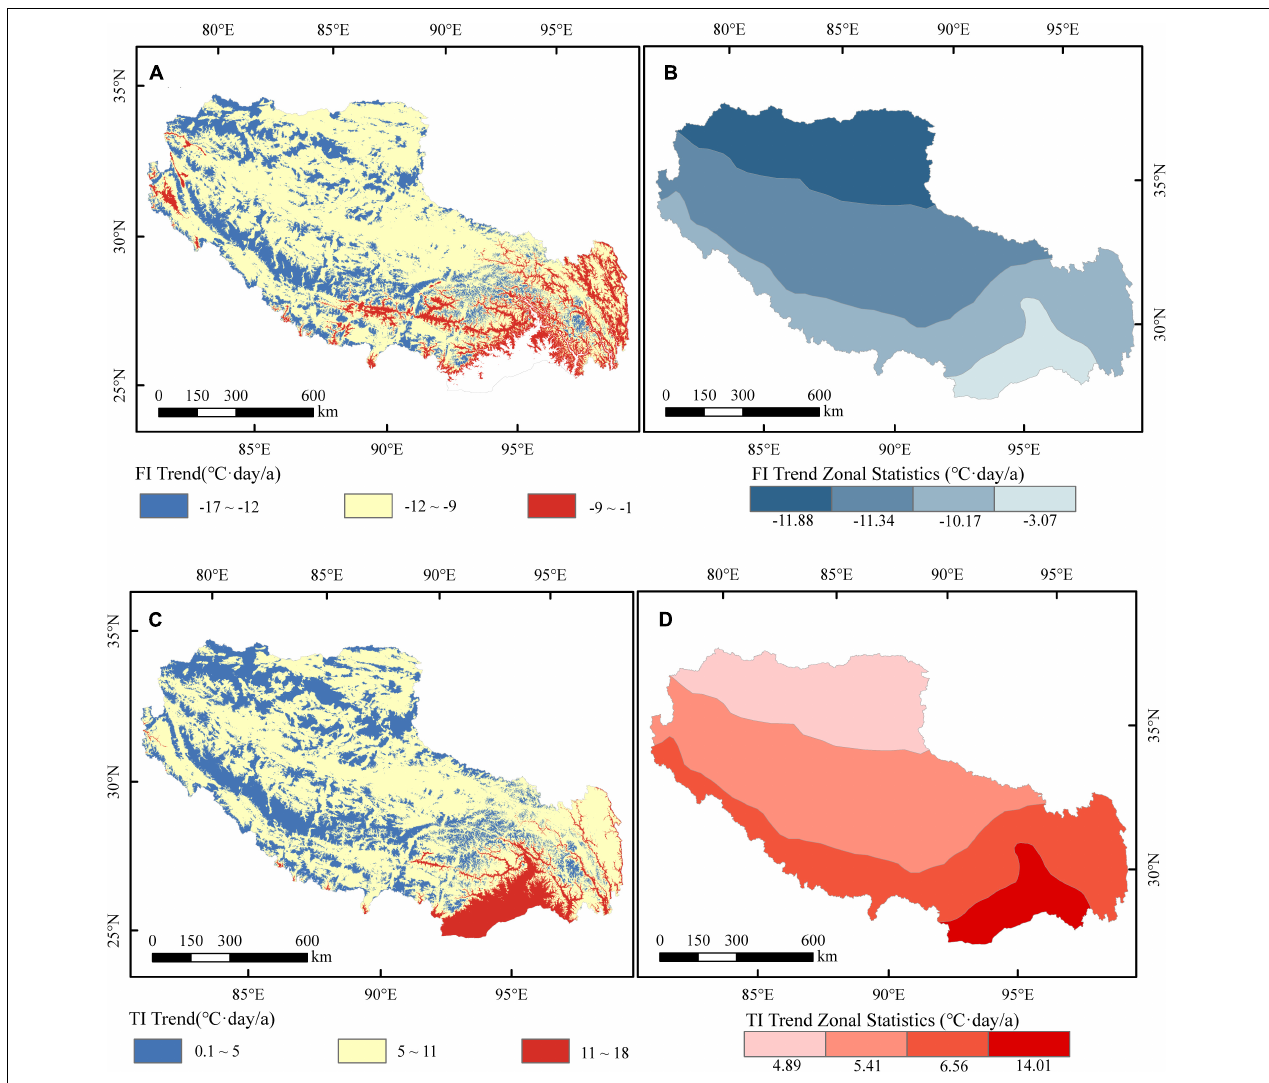
FIGURE 4 | (A) Trends ( ◦ C · day/a) for the FI over Tibet from 1978 to 2017 and (B) 4 parts zonal statistics. (C) Trends ( ◦ C · day/a) for the TI over Tibet from 1978 to 2017 and (D) 4 parts zonal statistics. Note that the white area has no FI and TI changing